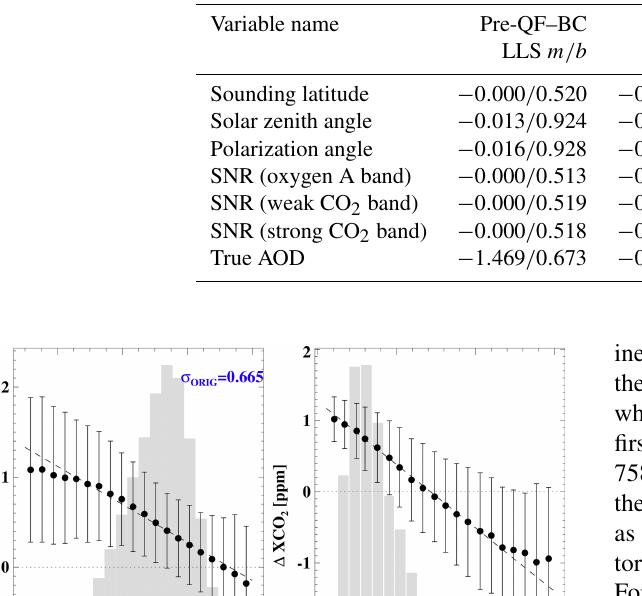
Table 6. The slope ( m ) and offset ( b ) of a linear least-squares fit (LLS) and Pearson linear correlation coefficient ( R ) for (cid:49) XCO 2 versus geophysical parameters before and after application of the QF–BC procedure. Data are for the full annual glint–water soundings only.